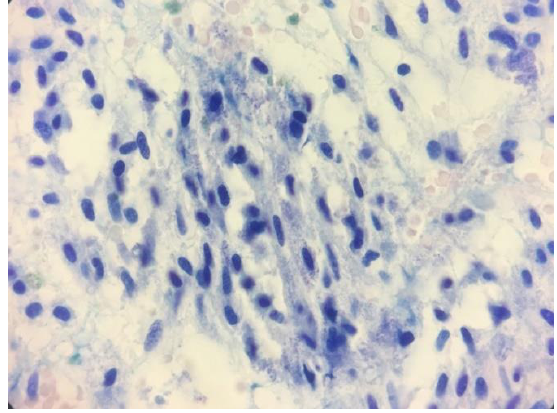
Figure 3. Bone marrow biopsy revealed numerous mast cells with metachromatic granules. (Toluidine blue stain, 400×)